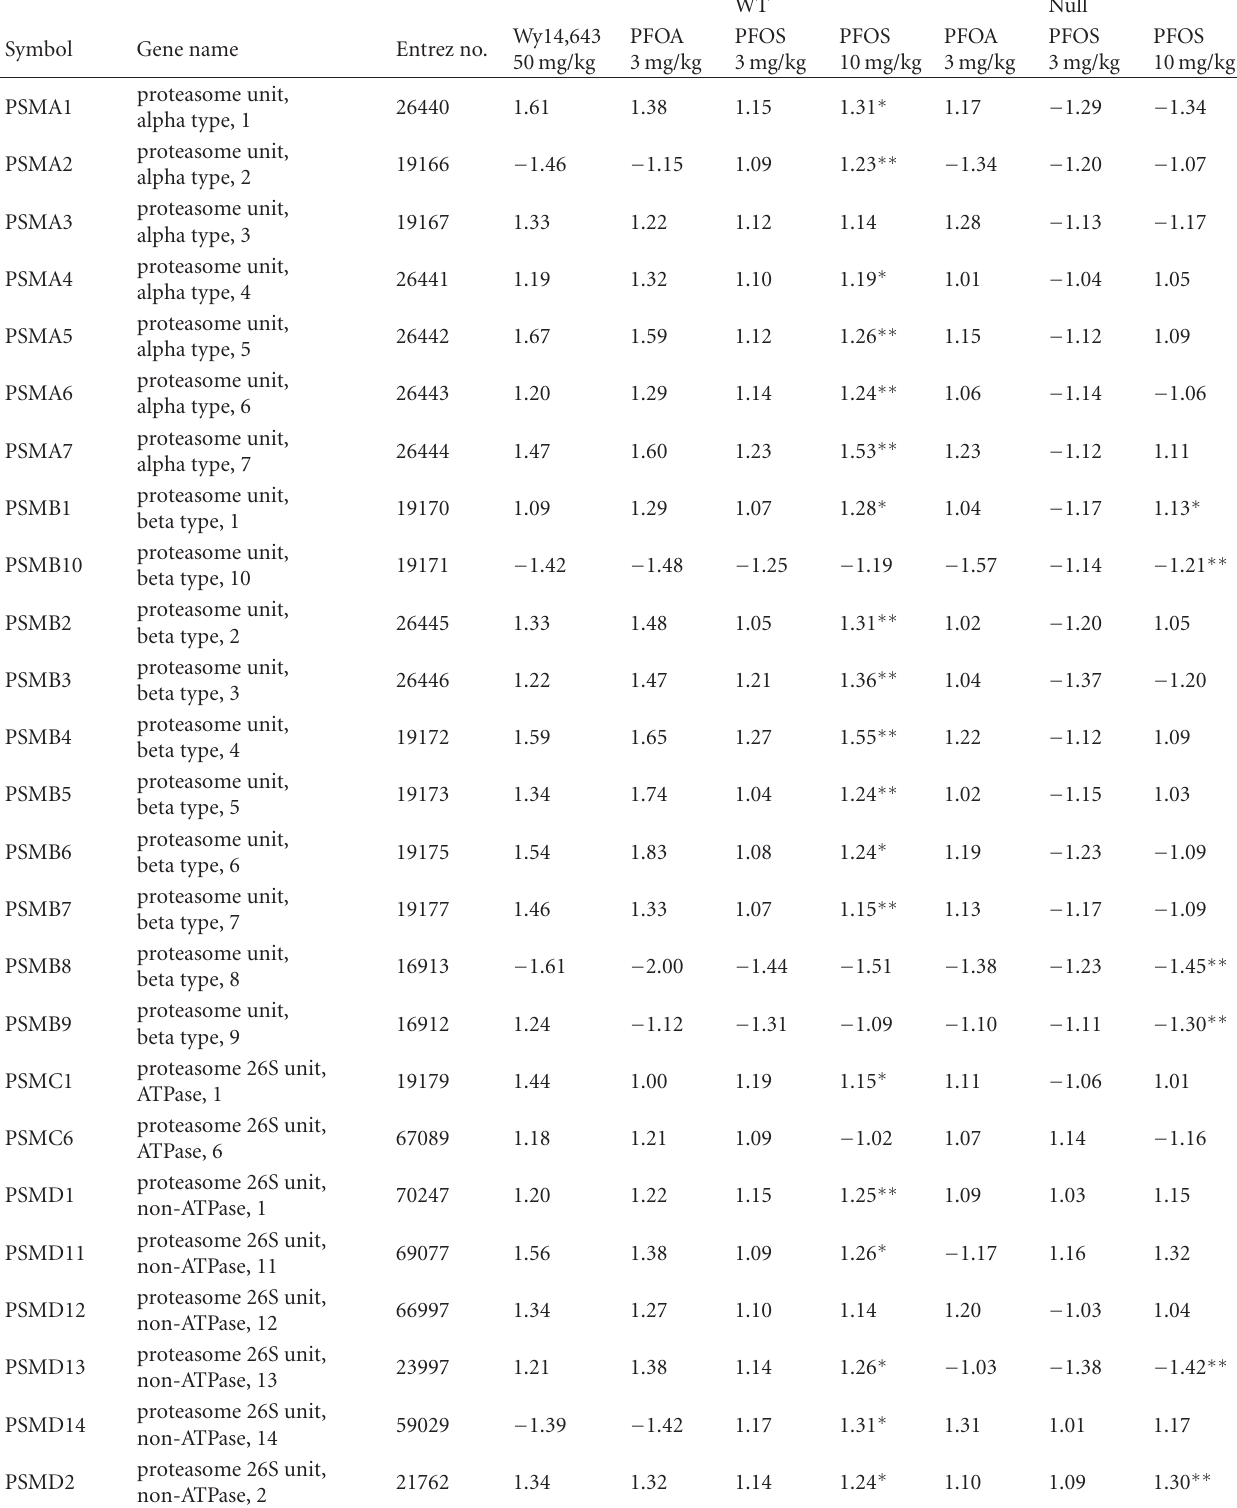
Table 4: Average fold change for genes related to proteasome biogenesis in wild-type and PPAR α -null male mice following a seven-day exposure to Wy-14,643 1 , PFOA 1 , or